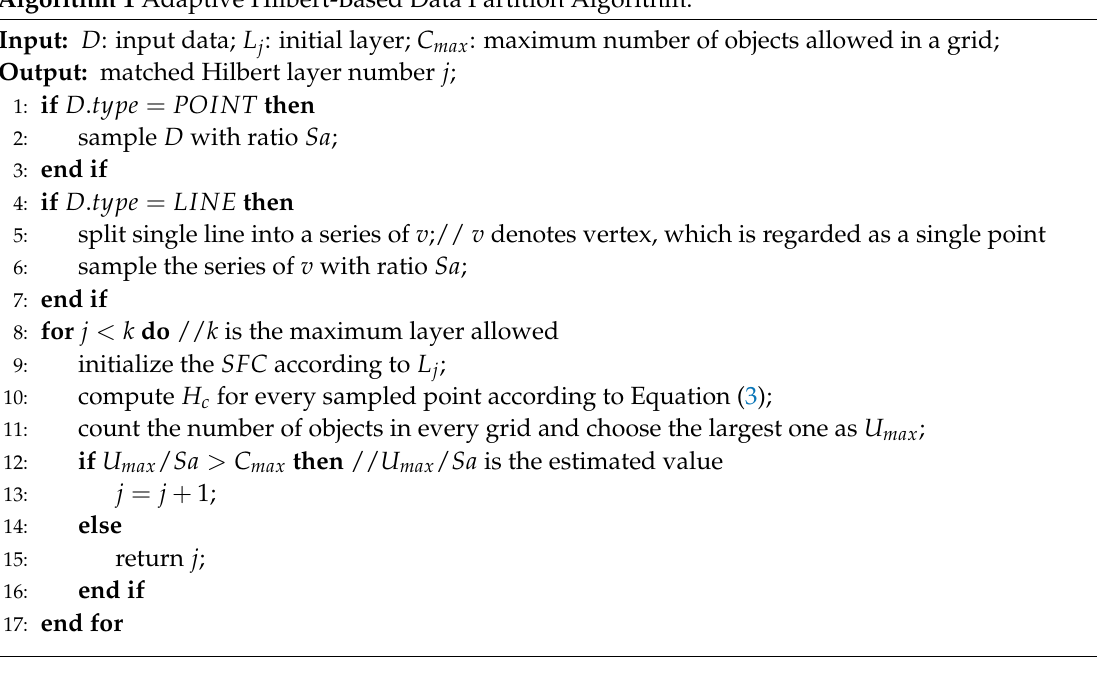
Algorithm 1 Adaptive Hilbert-Based Data Partition